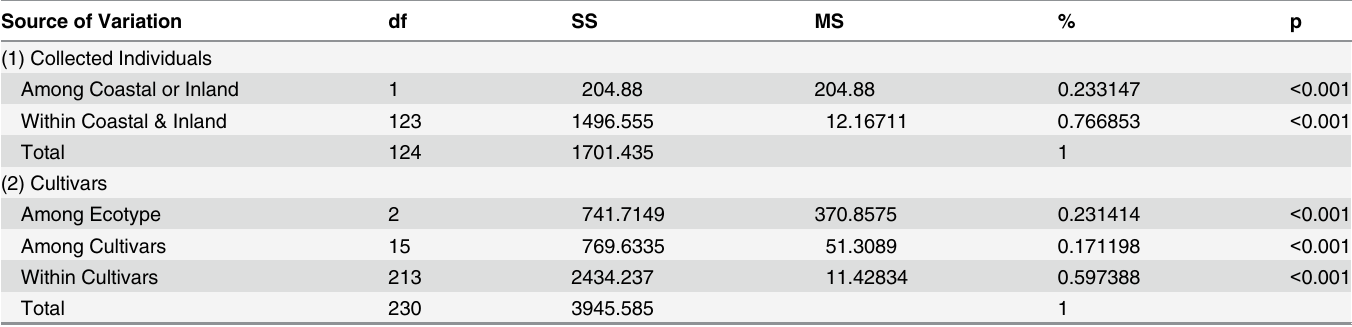
Table 3. Analysis of molecular